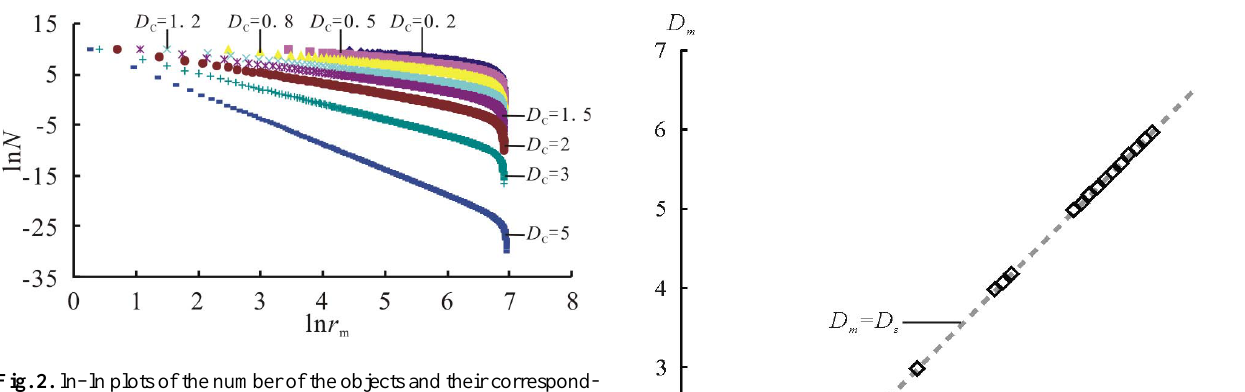
Fig. 2. ln–ln plots of the number of the objects and their correspond- ing average sizes with r c ranging from 1 to 1000 and D c varying from 0.2 to 5.